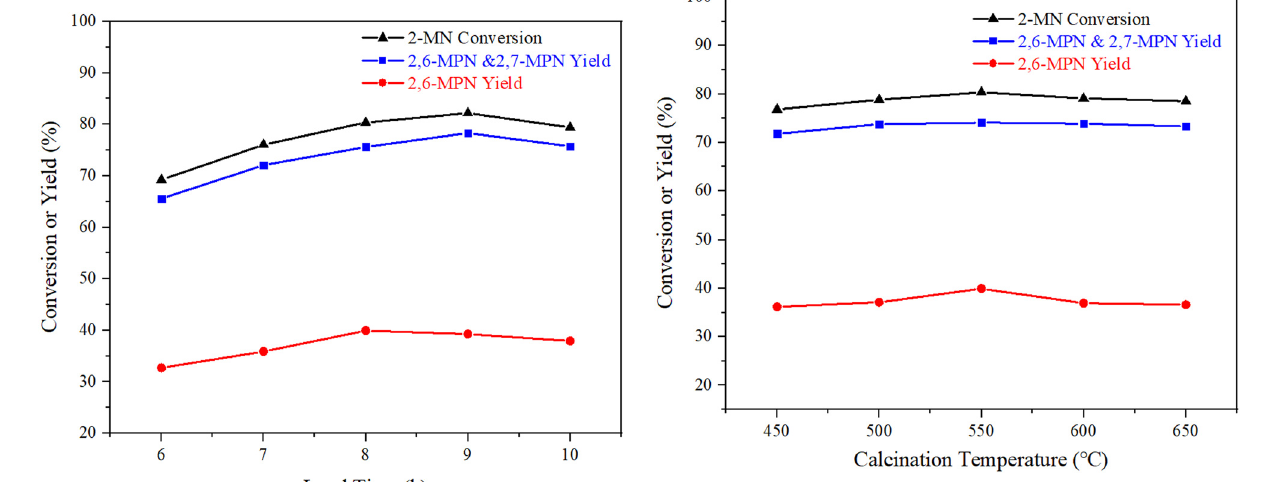
Figure 8: In fl uence of calcination temperature on the performance of 2 - MN propionyl catalyzed by AlCl 3 /H β . Reaction conditions: n ( n ( = 1:1.8, TS 10 g, AlCl β ( AlCl · L − 1 , re fl ux for 9 h 2 - MN ) : PA ) 3 /H 3 g and calcination for 3 h ) 3 g, 190°C, 10